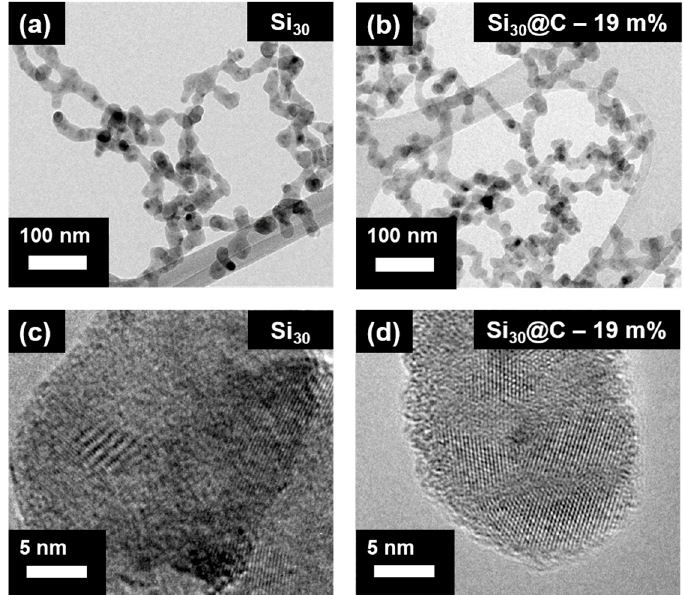
Figure 1. TEM micrographs of Si ( a ) and Si@C ( b ) nanoparticles where the typical chain-like mor- phology can be observed. ( c , d ) represent the same materials at a higher magnification. A shell of amorphous carbon is observed at the edge of the Si@C particles on ( d ).